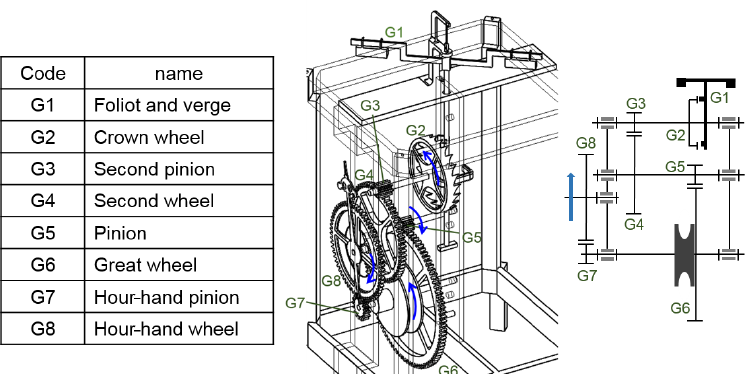
Figure 3. Going system of the Liechti iron chamber clock (N2).